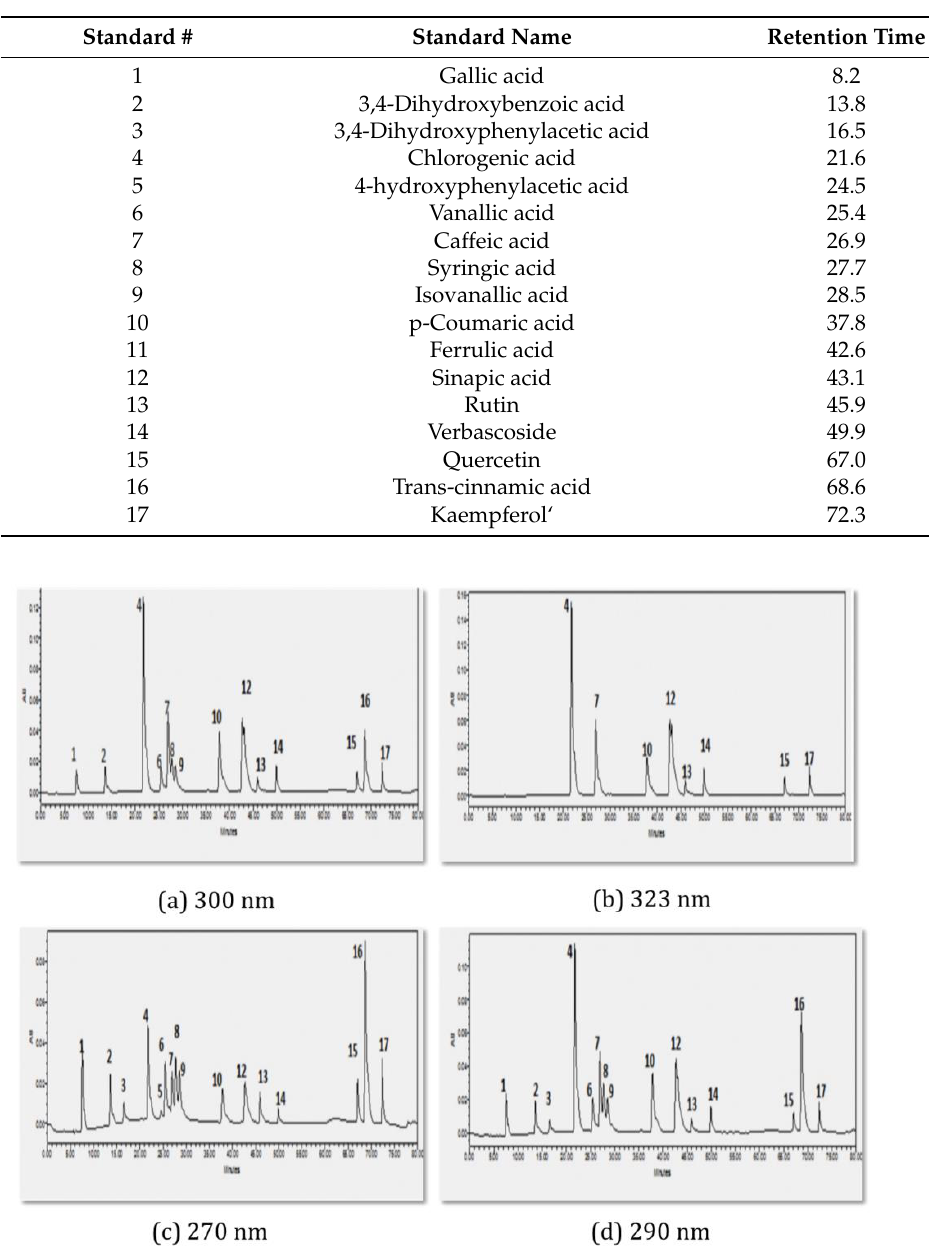
Figure 2. HPLC chromatogram of polyphenolic and flavonoid standards analysed using RP-HPLC method at ( a ) 300 nm; ( b ) 323 nm; ( c ) 270 nm; and ( d ) 290. Table 2. HPLC retention times for selected standard compounds.